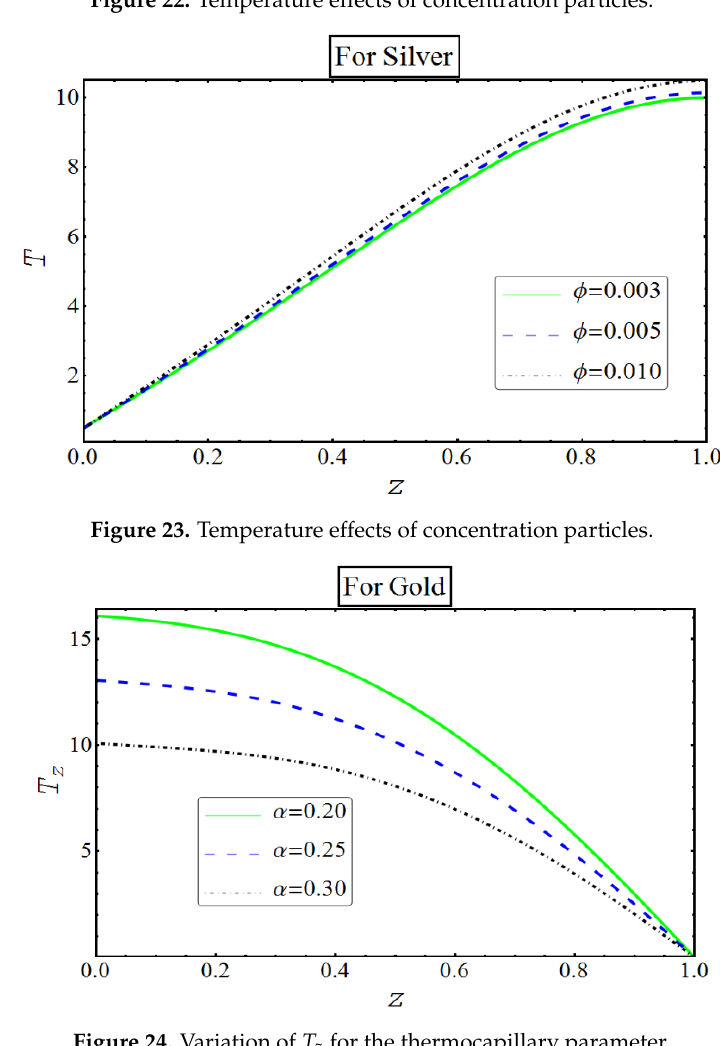
Figure 25. Variation of 𝑇 𝑧 for the thermocapillary parameter. Figure 26. Variation of 𝑇 𝑧 on concentration particles.